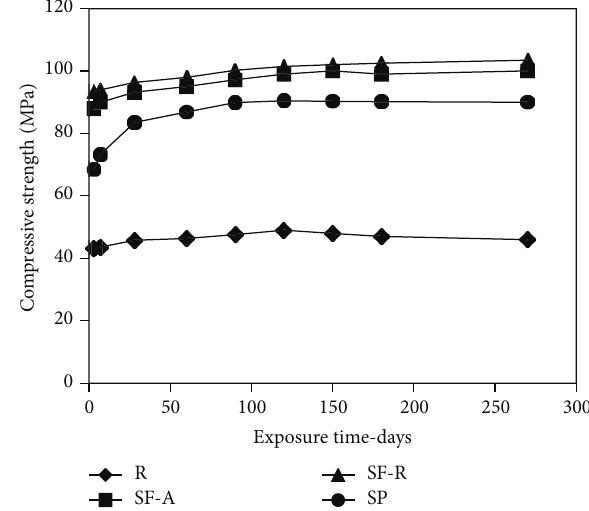
Figure 10: Electrical resistance at 90 days.